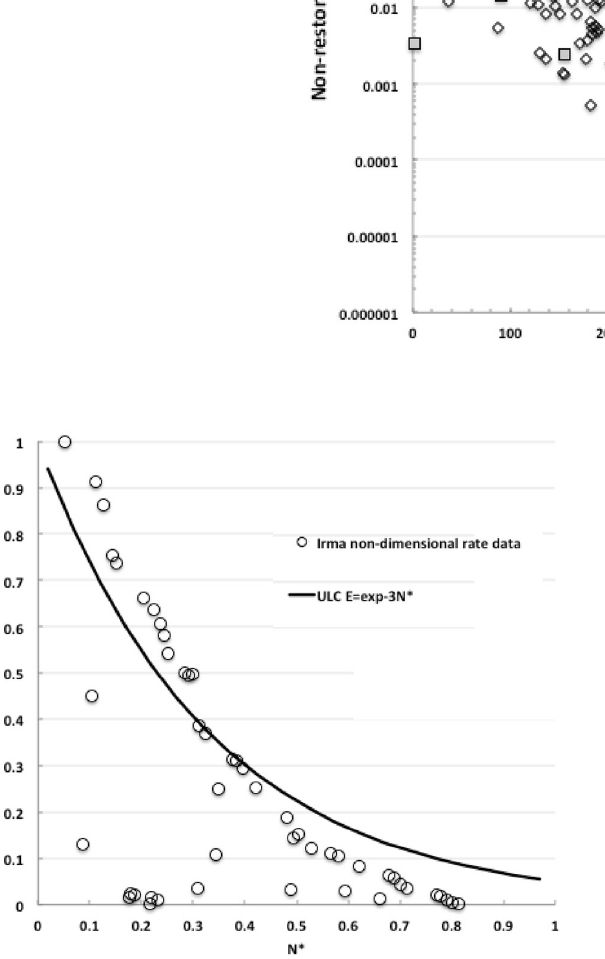
Fig. 6 Comparison of Irma non-restoration rate data to the non- dimensional Universal Learning Curve (ULC) (Duffey and Saull